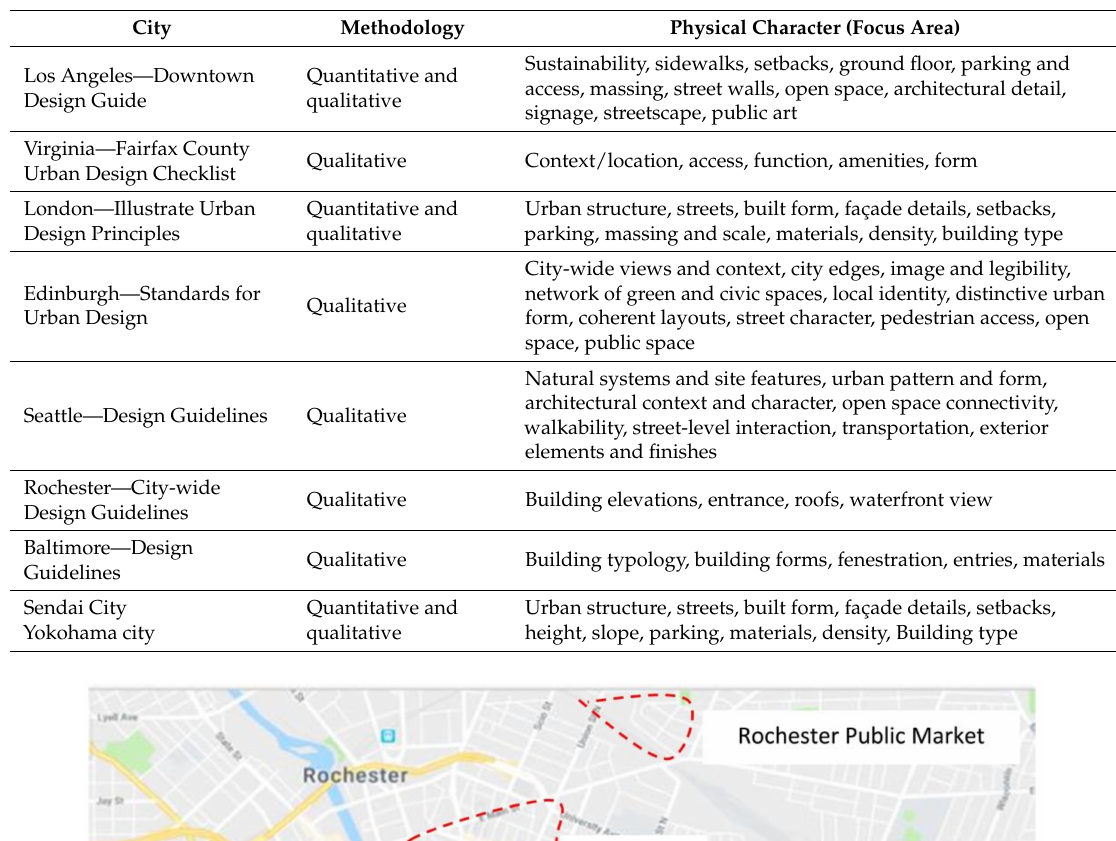
Table 1. Design guidelines.